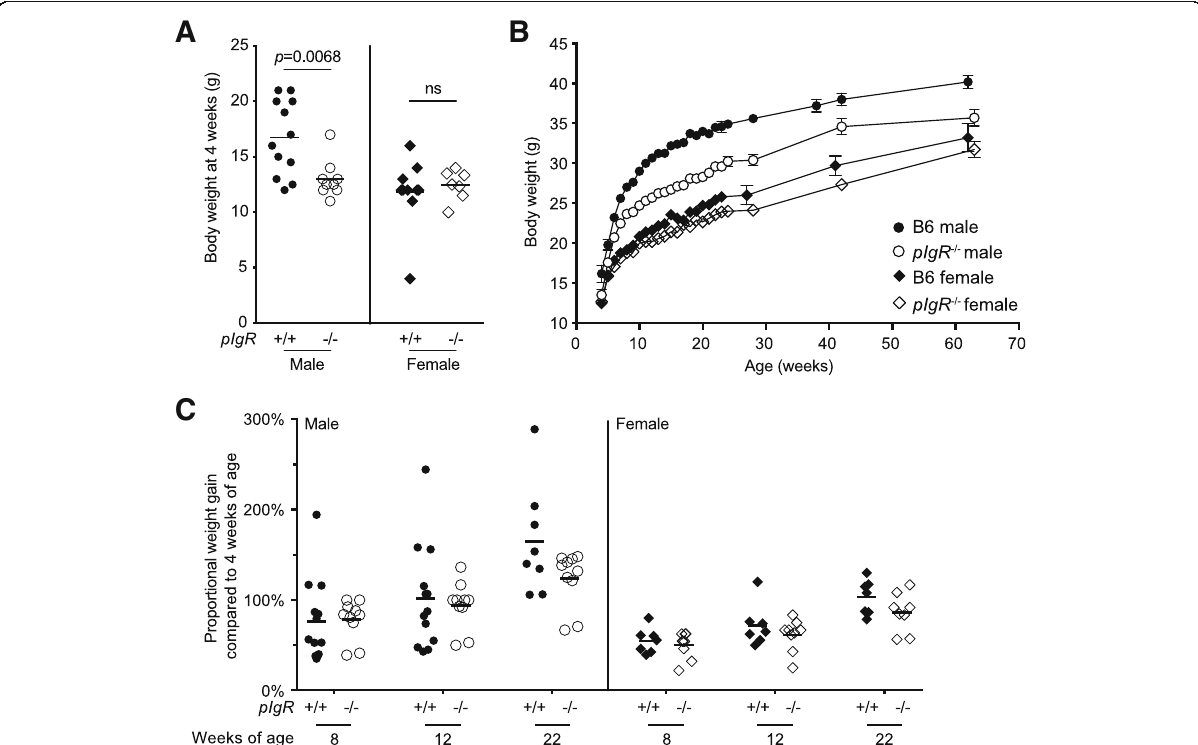
Fig. 3 Effect of pIgR deletion on mouse body weight in B6 mice. Cohorts of age- and sex-matched male (closed circle, B6 n = 15; open circle, pIgR − / − n = 10) and female (closed diamond, B6 n = 10; open diamond, pIgR − / − n = 10) mice were weighed at indicated age. Shown are a body weight of individual mice at 4 weeks of age; and b mean ± SEM body weight over a 65-week time course. c Proportional weight gain is calculated as weight gained since 4 weeks of age as a percentage of 4-week body weight of the same